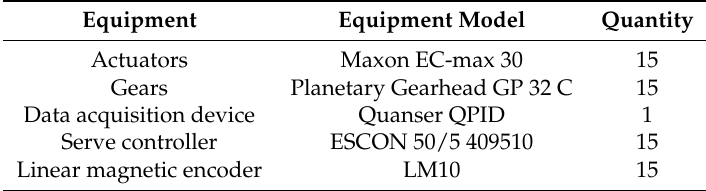
Table 2. Equipment model